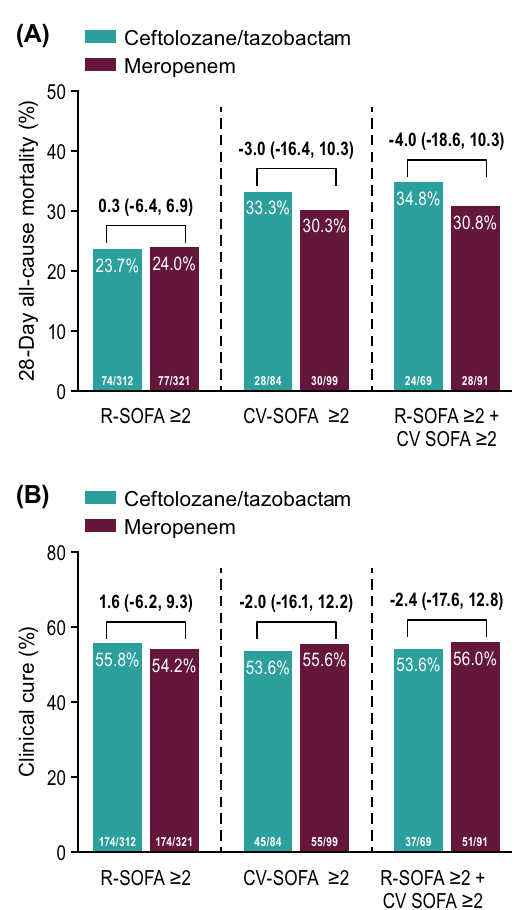
Fig. 3 Mortality (upper panel A ) and cure at TOC (bottom panel B ) by SOFA component score (ITT population). Treatment differences were calculated as unstratified Newcombe 95% CIs; positive differences are in favor of ceftolozane/tazobactam, negative differences are in favor of meropenem. Participants whose 28‑day mortality outcome was missing or unknown were analyzed as deceased. Participants with clinical failure at the EOT visit were counted as failures at the TOC visit. CI confidence interval, CV-SOFA cardiovascular, EOT end‑of‑therapy, R-SOFA respiratory SOFA component score, SOFA Sequential Organ Failure Assessment, TOC